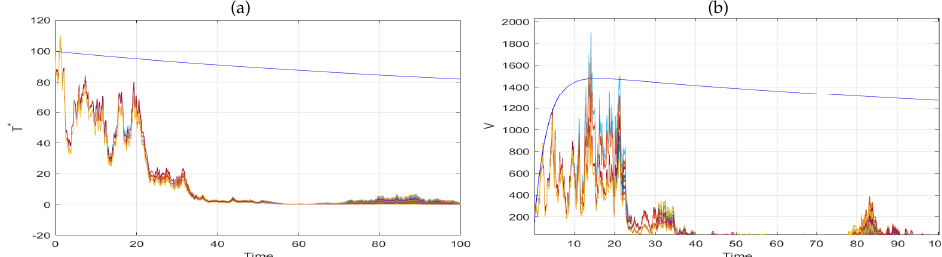
≈ 0.7278 < 1, where 500 trajectories have Figure 4. The trajectories distribution of model (2) with R s 0 the same initial value: ( a ) trajectories of T ∗ ( t ) ; ( b ) trajectories of V ( t ) . Here, blue curve is without stochastic perturbation, other color oscillation curves are with stochastic perturbation. This implies that that even with the perturbation of uncertainties, the virus remains extinct with high probability < 1 can be used as a basis for carving out the extinction of the virus. and the R s 0